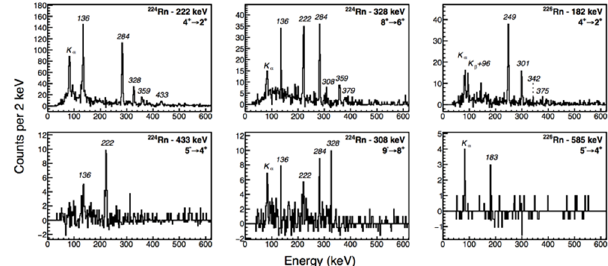
Figure 2. Coincidence γ -ray spectra. The representative background-subtracted γ -ray spectra are in time-coincidence with different gating transitions. Here the observed peaks are labelled by the energy (in keV) of the transition. The gating transition is additionally labelled by the proposed spin and parity of the initial and final states.